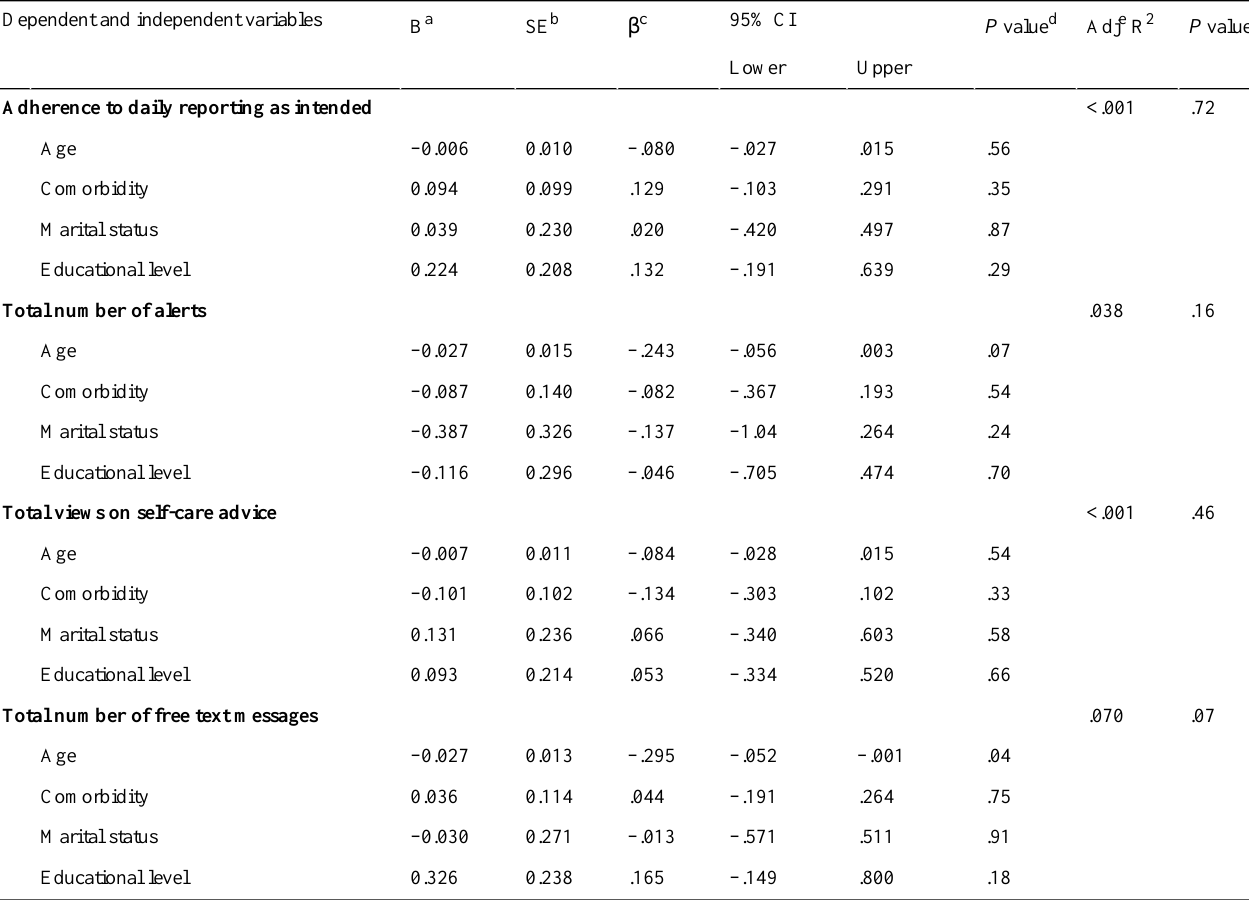
Table 4. Multiple regression in patients with breast cancer